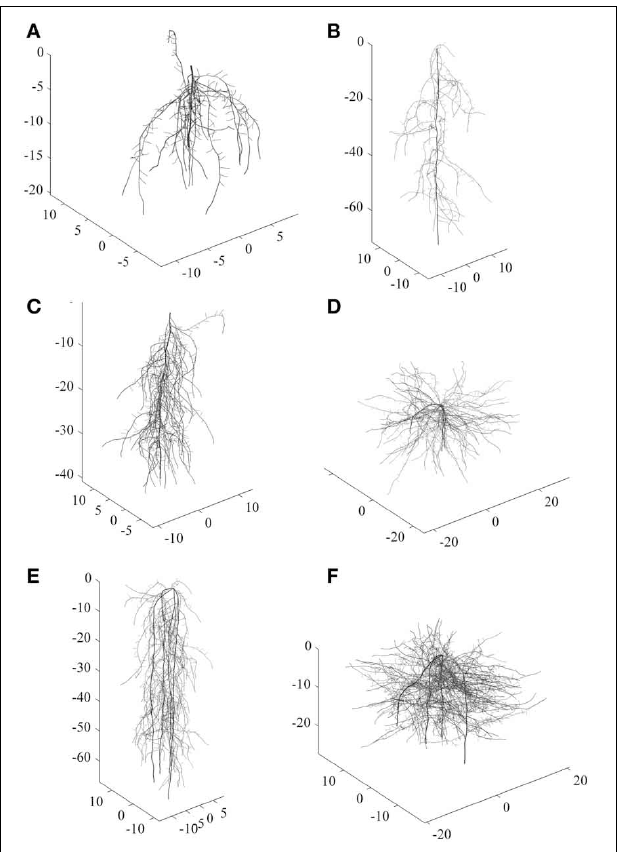
FIGURE 1 | Examples of simulated root systems corresponding to six main clusters. (A–C) are tap root systems (one zero-order axes) differing in vertical root distribution and branching intensity, (D–F) are shoot-borne root systems (four zero-order axes) with different vertical distribution and branching intensity. (A) and (B) are more herringbone systems while (D) and (F) are typical dichotomous